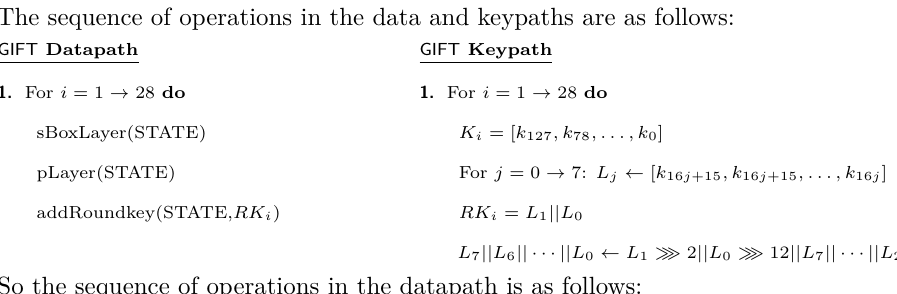
Figure 14: Modified logic around the last 4 flip-flops to accommodate decryption H Circuit Details for